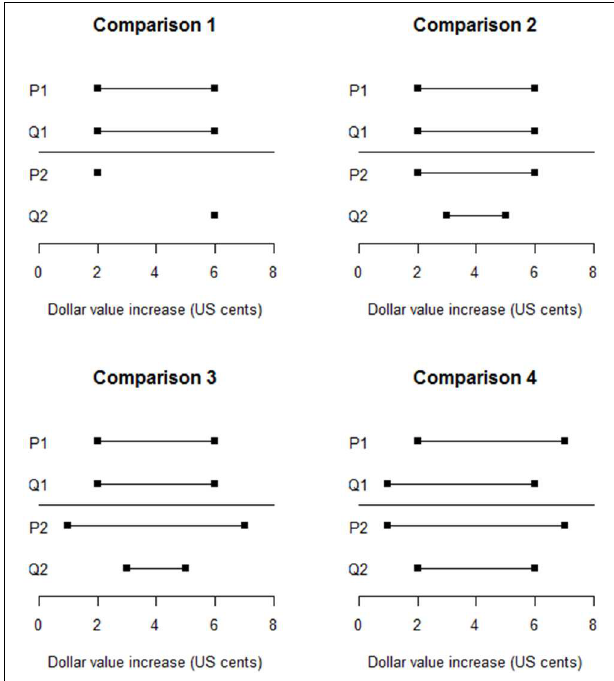
FIGURE 1 | Four pairs of judged probability